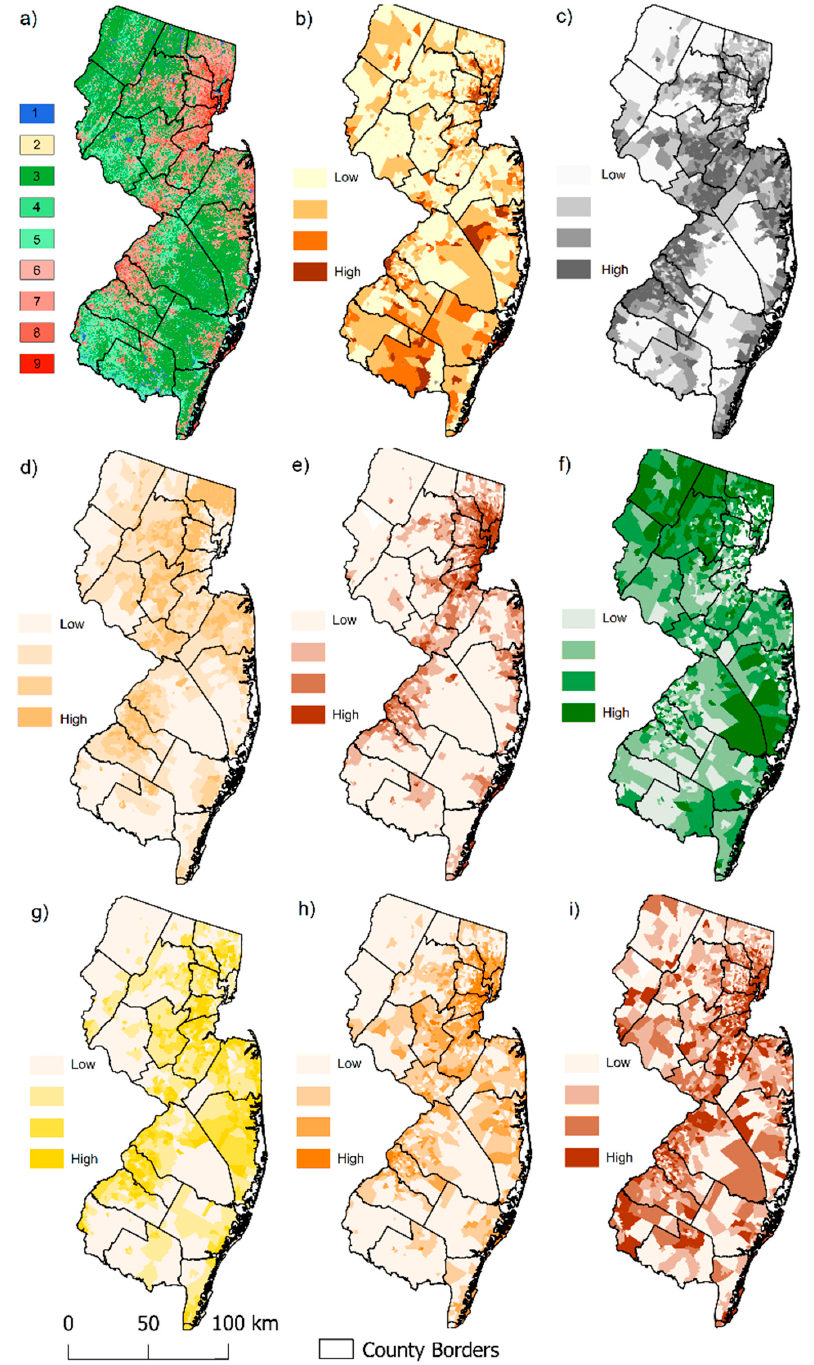
Figure 1. Land cover classification and landscape characteristics of New Jersey: ( a ) Reclassified land cover classification (1 = Water, 2 = Sand/Bare, 3 = Forest, 4 = Shrubs, 5 = Grass, 6 = Open, 7 = Low, 8 = Medium, 9 = High intensity developed lands); ( b ) Census tract poverty level by categories (0–5%, 5–10%, 10–20%, 20+%); ( c ) Shannon Diversity Index (SHDI) by quartiles low to high; ( d ) Proportion of open developed lands by quartiles low to high; ( e ) Proportion of high-intensity developed lands by quartiles, low to high; ( f ) Forest contiguity index by quartiles, low to high; ( g ) Aggregation index (AI) of open developed lands by quartiles, low to high; ( h ) Aggregation index (AI) of medium-intensity developed lands by quartiles, low to high; ( i ) Aggregation index (AI) of high-intensity developed lands by quartiles, low to high.